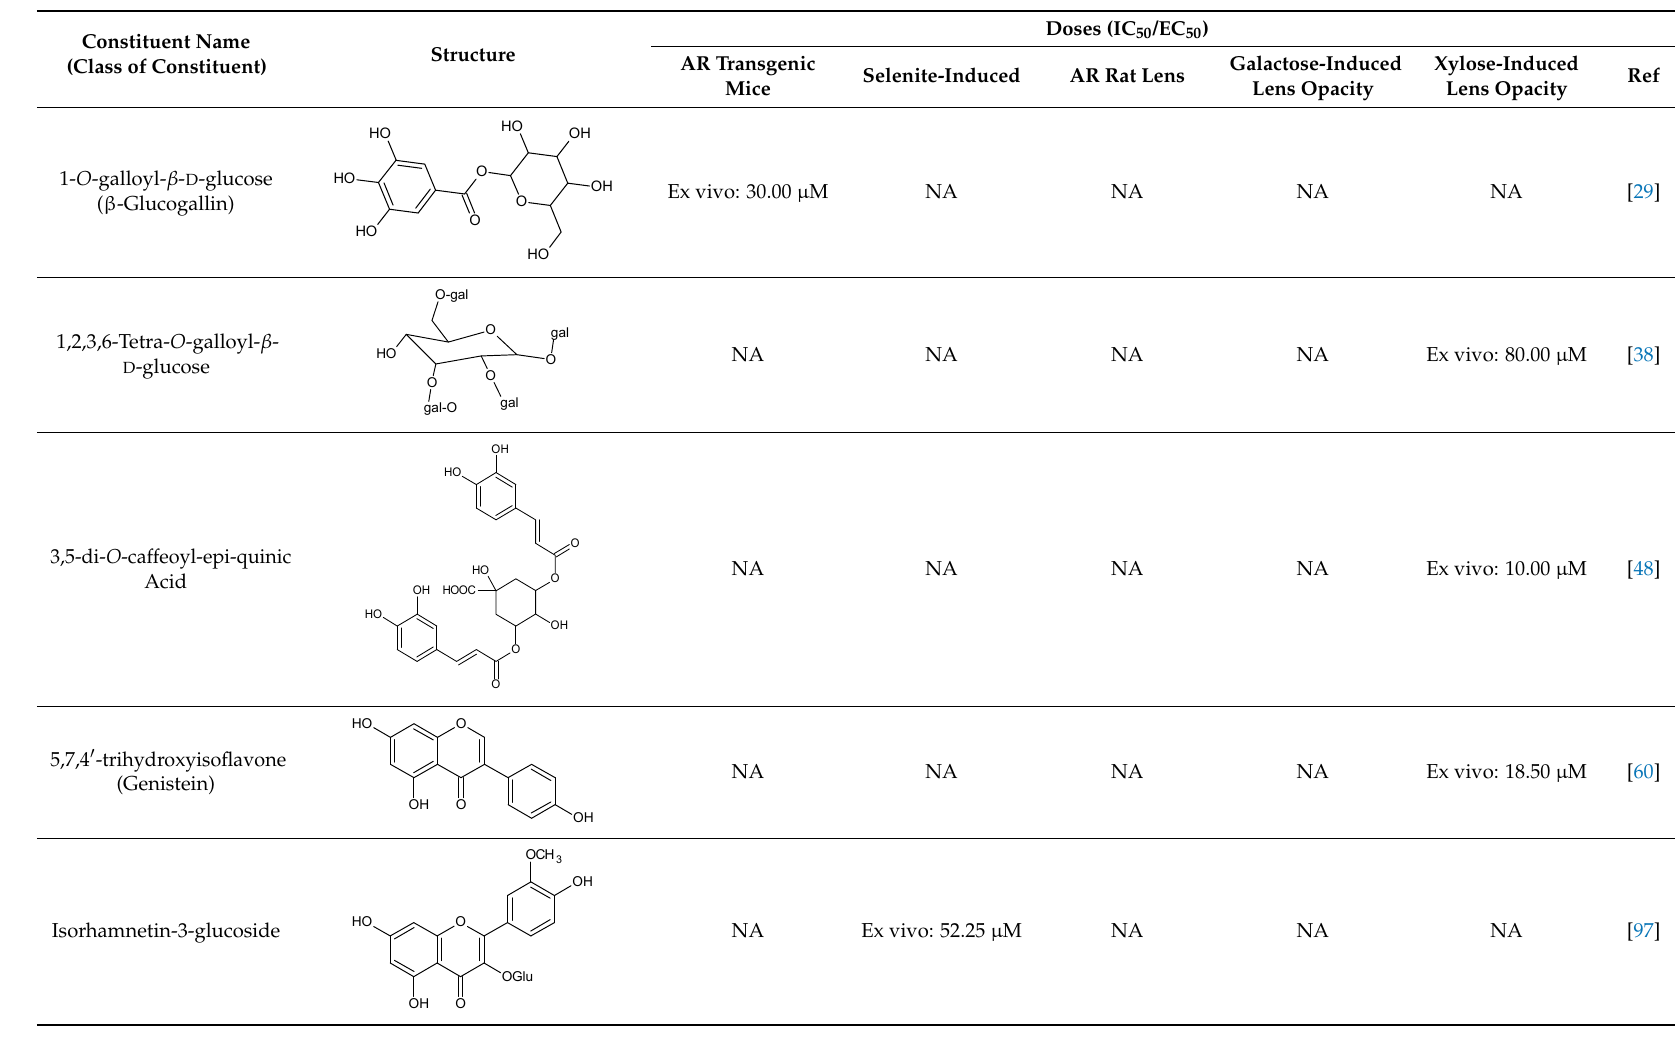
Table 2. Summary of relevant ex vivo and in vivo activities of phytoconstituents.